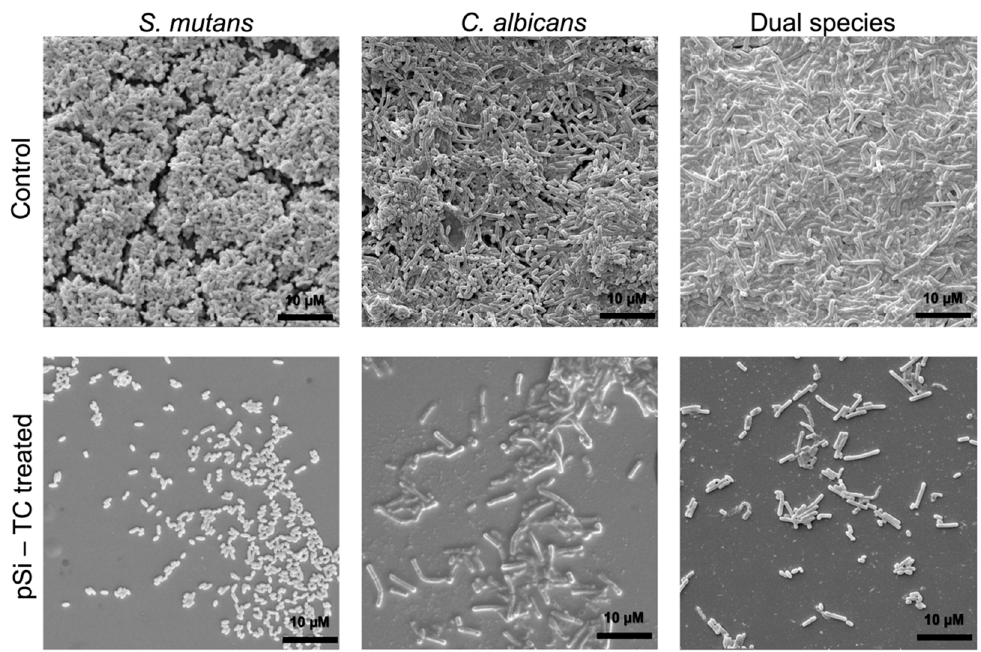
Figure 7. Scanning Electron Microscopic examination of biofilms of S. mutans , C. albicans and Dual- species biofilms with and without treatment with pSi-TC, showing dense biofilm aggregates with a thick biofilm matrix in the untreated control, while pSi-TC treated biofilms show scattered microbial cells and an overall reduction in the number of cells, indicating no biofilm formation.